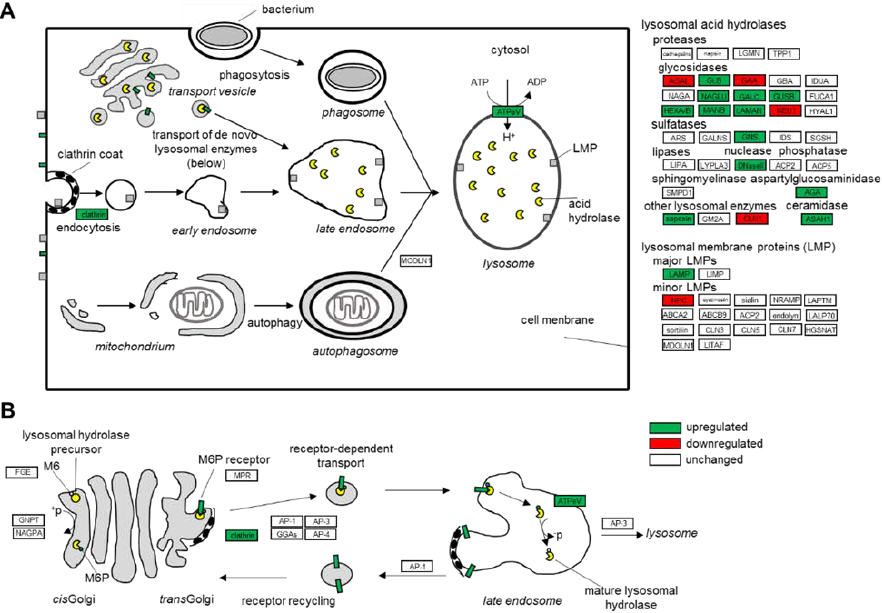
Figure 8. Overview of mainly dysregulated proteins in AGAL-deficient podocytes compared to wild-type. ( A ) Overall lysosomal-associated proteins. ( B ) Translocation between the Golgi com-plex and the late